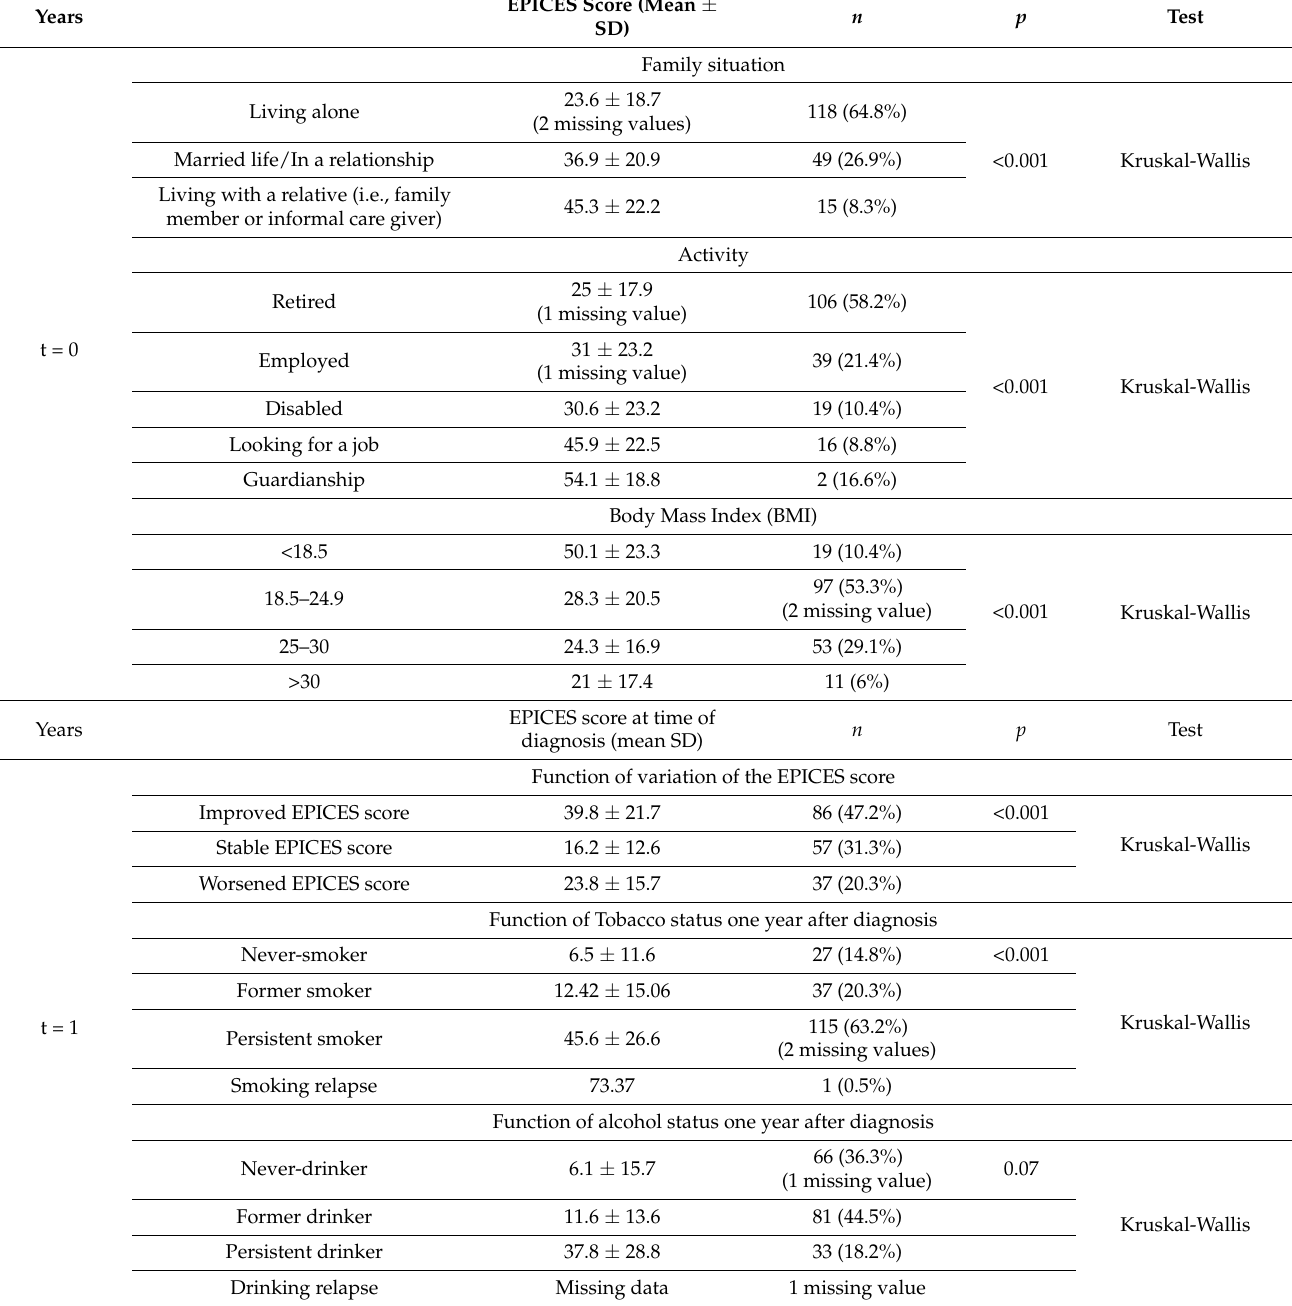
Table 4. Univariate analysis according to social deprivation (EPICES